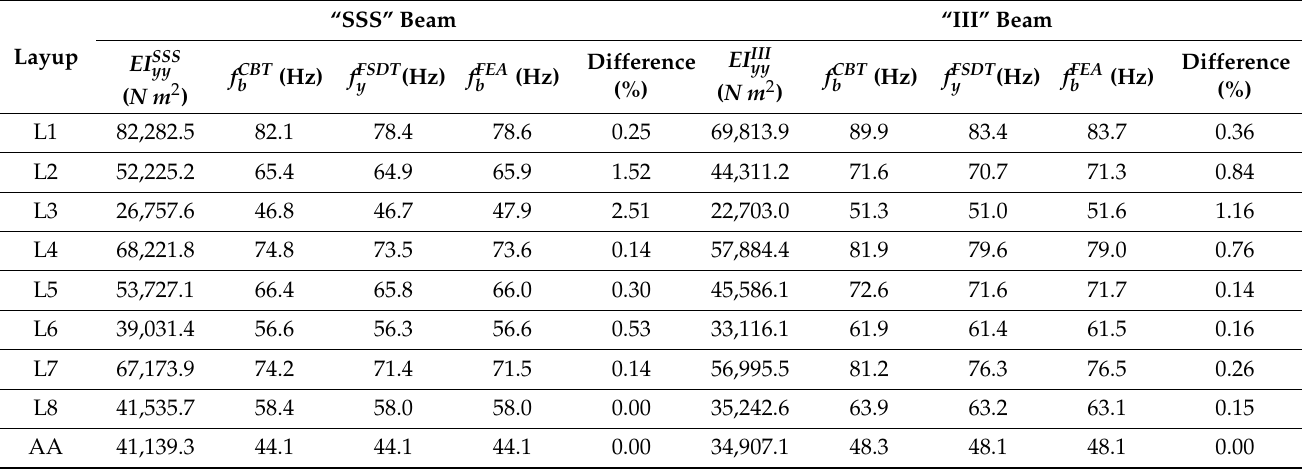
Table 6. Fundamental natural frequencies of the eight different layups for “SSS” and “III” cantilever beams (see Table 2 for details of